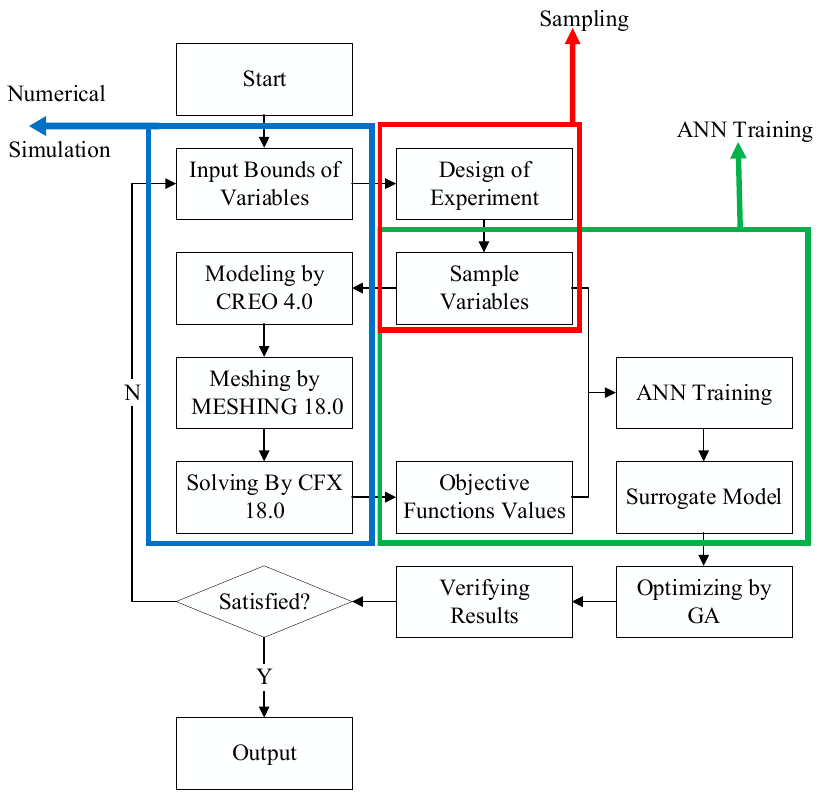
Figure 6. Flowchart of Optimization process.